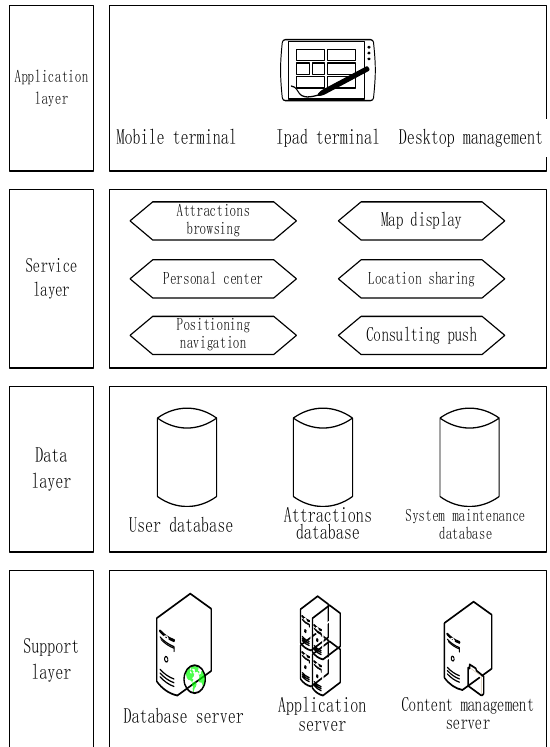
Figure 2. Intelligent tour guide system architecture